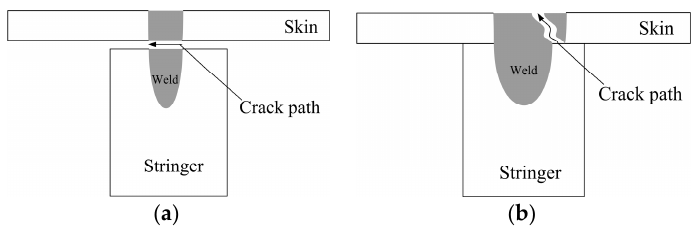
Figure15. Schematic illustration of sample failure modes: ( a ) failed across the faying surface; ( b ) failed in the weld of skin.